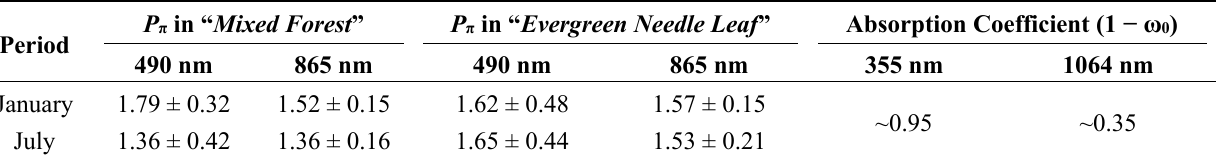
Table 2. Backscatter scattering phase function ( P π ) derived from the multi-angular satellite POLDER data. The absorption coefficient is also